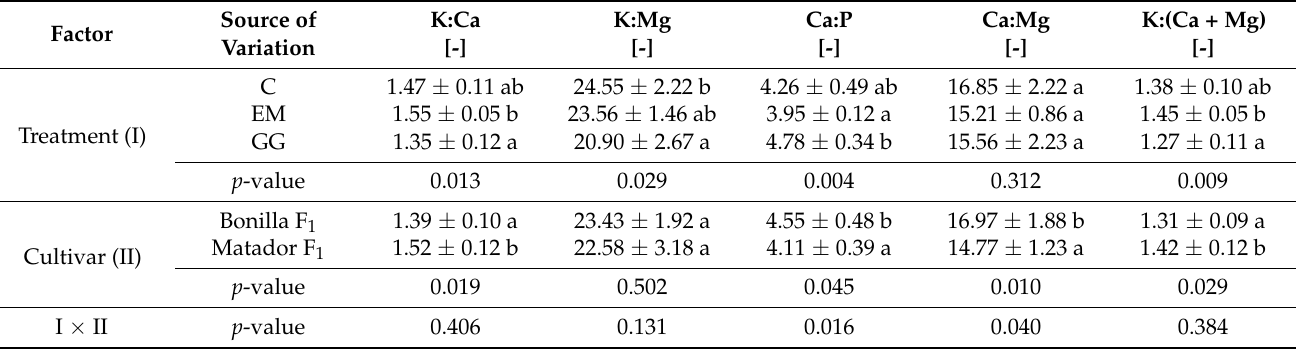
Table 8. Macronutrient ratios in shallot bulbs.